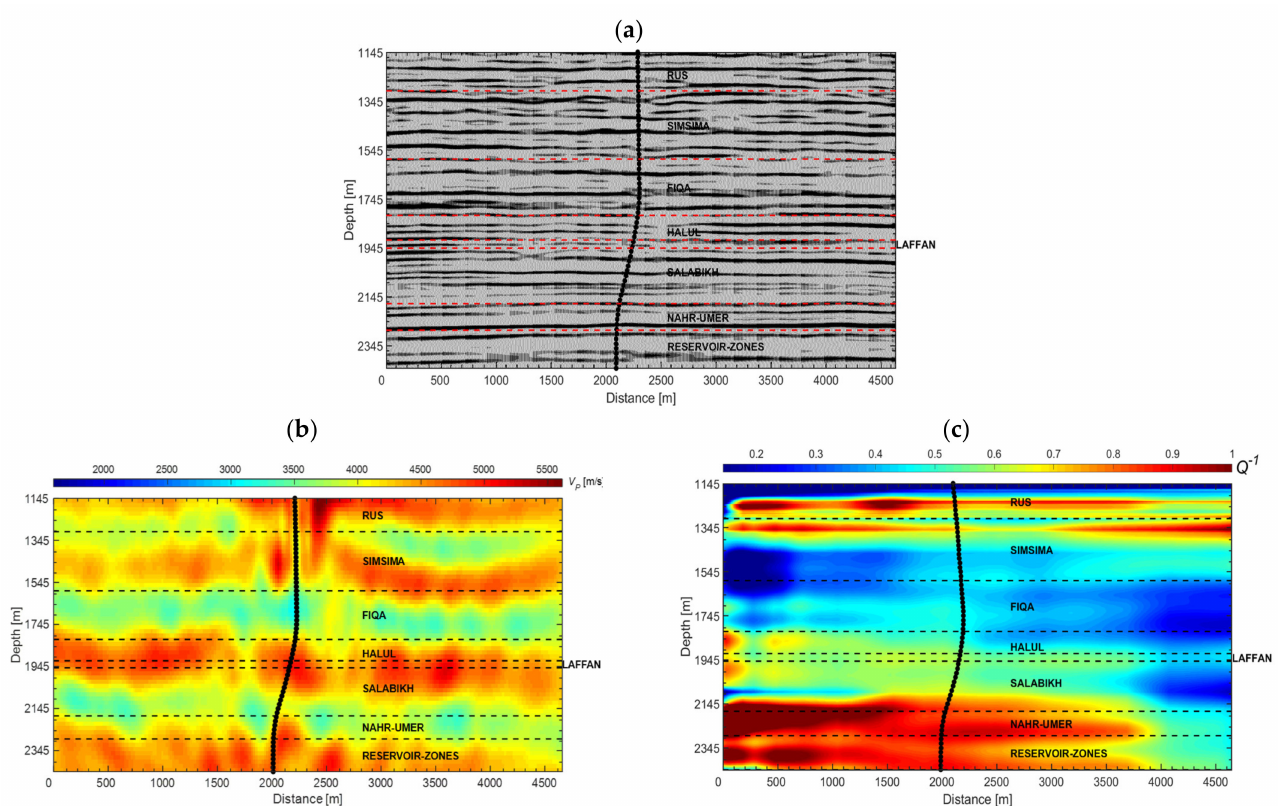
Figure 14. ( a ) Post-stack migrated section of the 3D VSP along an azimuth of 56 ◦ . ( b ) Smoothed com- pressional velocity profile obtained from full waveform inversion of the VSP data [26]. ( c ) Normalized and smoothed attenuation profile obtained from hydrophone data. All the profiles were obtained along an azimuth of 56 ◦ as highlighted in magenta color in Figure 2. The dashed horizontal lines and the text labels indicate the tops and names of the various geological formations respectively, while the black dots indicate the downhole